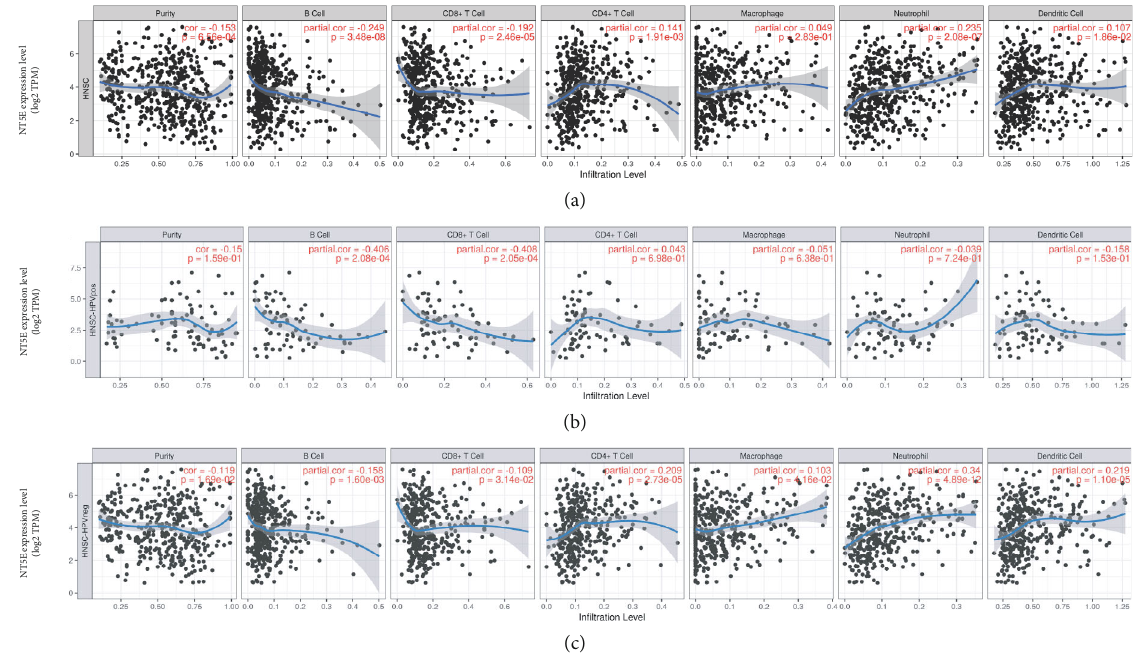
Figure 5: (a) Immune in fi ltration analysis of NT5E in HNSCC: the expression of NT5E was signi fi cantly correlated with B cells, CD8+T cells, CD4 + T cells, neutrophils, and dendritic cells in HNSCC. (b) Immune in fi ltration analysis of NT5E in HPV-positive HNSCC. The expression of NT5E was signi fi cantly correlated with B cells, CD8+T cells in HPV-positive HNSCC. (c) Immune in fi ltration analysis of NT5E in HPV-negative HNSCC. The expression of NT5E was signi fi cantly correlated with B cells, CD8 + T cells, CD4 + T cells, macrophages, neutrophils, and dendritic cells in HPV-negative